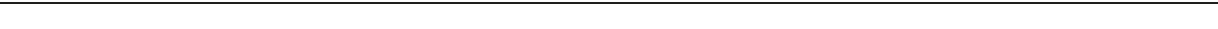
Fig. 5 The RidL 9 – 258 β -hairpin displaces TBC1D5 from the retromer. a HeLa cells were transiently transfected with vectors producing the GFP-fusion proteins or GFP as indicated and immuno-stained for TBC1D5 (cyan) and the retromer (Vps26; red). Scale bar, 10 μ m. b Co-localization of TBC1D5 with retromer (Vps26) shown in a was scored. Pearson ’ s correlation coef fi cient was calculated in three independent experiments with at least 50 cells each (mean and SD of the means from each experiment; one way ANOVA; *** P < 0.001). c GFP-TBC1D5 and associated endogenous retromer components were pulled down from transiently transfected HeLa cell lysate. The retromer was eluted from immobilized GFP-TBC1D5 with puri fi ed RidL 10 – 258 , RidL 10 – 258 - Δβ -hairpin or no protein. Input lysate (lys, 1%), washed beads after elution (beads, 20%) and eluates (20%) were analyzed by SDS-PAGE, Western blot and immuno-staining of GFP (GFP-TBC1D5: 117 kDa), Vps35 (91 kDa), Vps26 (40 kDa) or RidL (RidL 10 – 258 : 29 kDa, RidL 10 – 258 - Δβ -hairpin: 27 kDa). The bands of retromer components were quanti fi ed relatively to the value for mock-treated beads (indicated in %). One representative experiment of three independent biological replicates is shown. m, marker. d HeLa cells were transiently transfected with vectors producing RidL 9 – 258 -GFP or GFP, and the traf fi cking of Shiga toxin subunit B (STxB)-Cy3 was analyzed by co-localization with the Golgi-marker GM130 after 30 min. RidL 9 – 258 -GFP did not affect traf fi cking of STxB-Cy3. As a positive control, GFP-producing cells were treated with 25 µ M Retro-2 30 min prior to and during the traf fi cking assay. Images shown are representative of three independent experiments. Scale bar, 10 µ